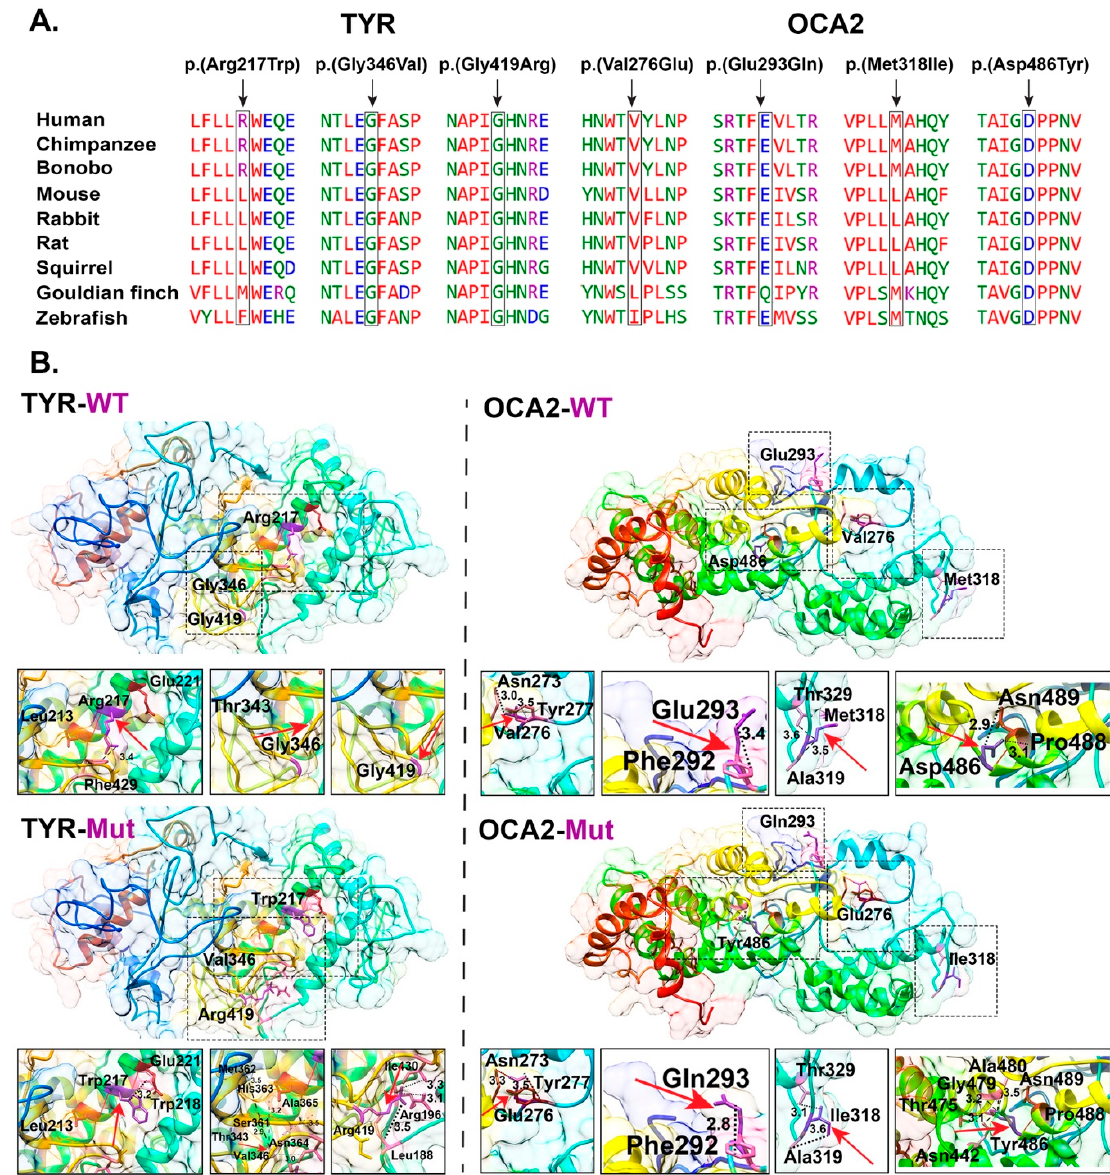
Figure 4. Clustal alignment and 3D protein modeling of TYR and OCA2 variants. A. Clustal alignment of TYR and OCA2 sequence across a number of species. B. Pair-wise comparison of TYR and OCA2 wild type (top) and mutant (bottom) residues (marked with arrows), predicted changes. Protein secondary structure is shown in ribbon and hydrophobic surface representation. Residues of interest are shown in purple, and hydrogen bonds are shown as solid red lines. Dotted black lines are used to show the distance of residue of interest with nearby residues. TYR: NM_000372.5 and OCA2: NM_000275.3.